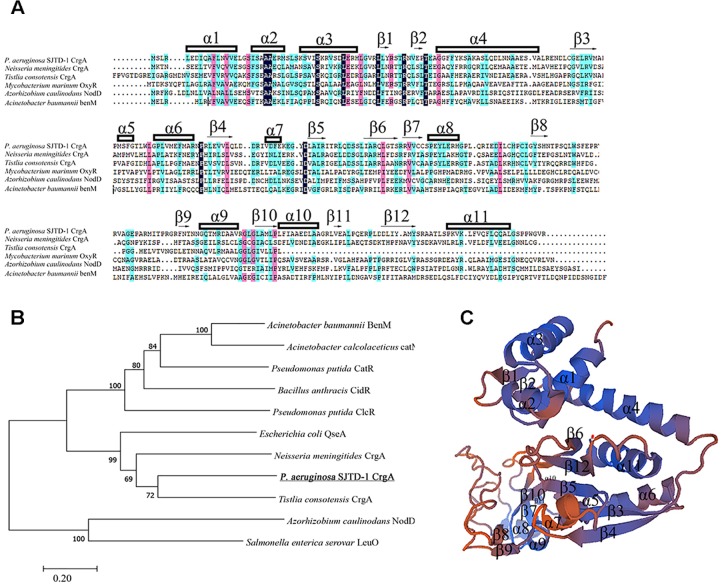
Multiple sequences alignment, evolutionary analysis and structure prediction of CrgA in P. aeruginosa SJTD-1. (A) Multiple sequences alignment of different CrgA homologues including the CrgA of P. aeruginosa SJTD-1 (ANI09566), CrgA of N. meningitides (AAF37819.1), CrgA of Tistlia consotensis (WP_085121968.1), OxyR of Mycobacterium marinum (WP_020729003.1), NodD of Azorhizobium caulinodans (AAA26190.1), and BenM of A. baumannii (WP_000423280.1). The α-helix and β-sheet were numbered and the conserved amino acids were marked. (B) The phylogenetic tree of CrgA in P. aeruginosa SJTD-1 and other LTTR regulators. The Kimura two-parameter distance model was used and bootstrap analysis was performed with 1,000 repetitions. (C) The predicted structure of CrgA in P. aeruginosa SJTD-1. The structure model was constructed by the homology-modeling method with CrgA of N. meningitides (3HHG) as the template.